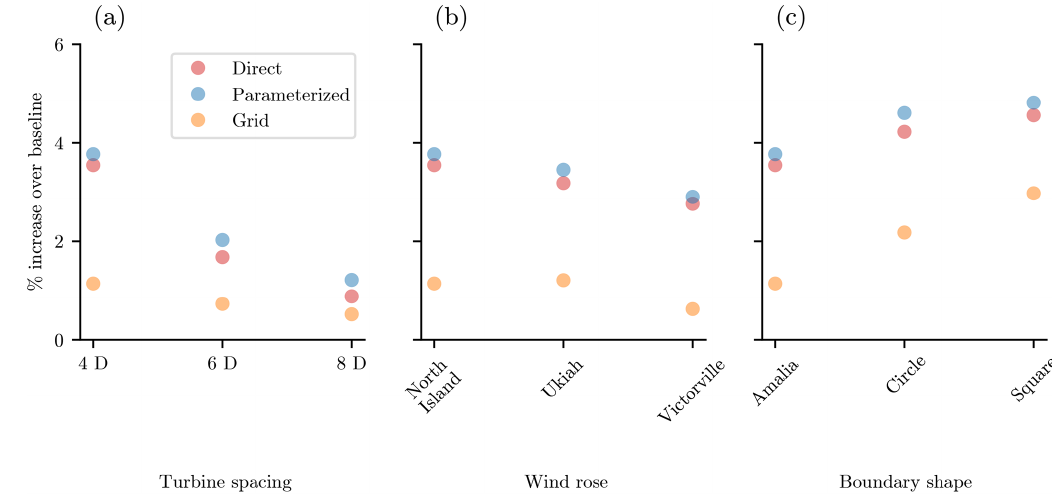
Figure 9. The best annual energy production achieved with 100 randomly initialized optimizations. Shown are the best results from the grid turbine parameterization (four design variables), our new boundary-grid parameterization method (five design variables), and by directly optimizing the location of each turbine (200 design variables). Results are shown as a percent increase over a baseline grid layout. (a) Varied average turbine spacing in the wind farm. (b) Varied wind rose. (c) Varied boundary